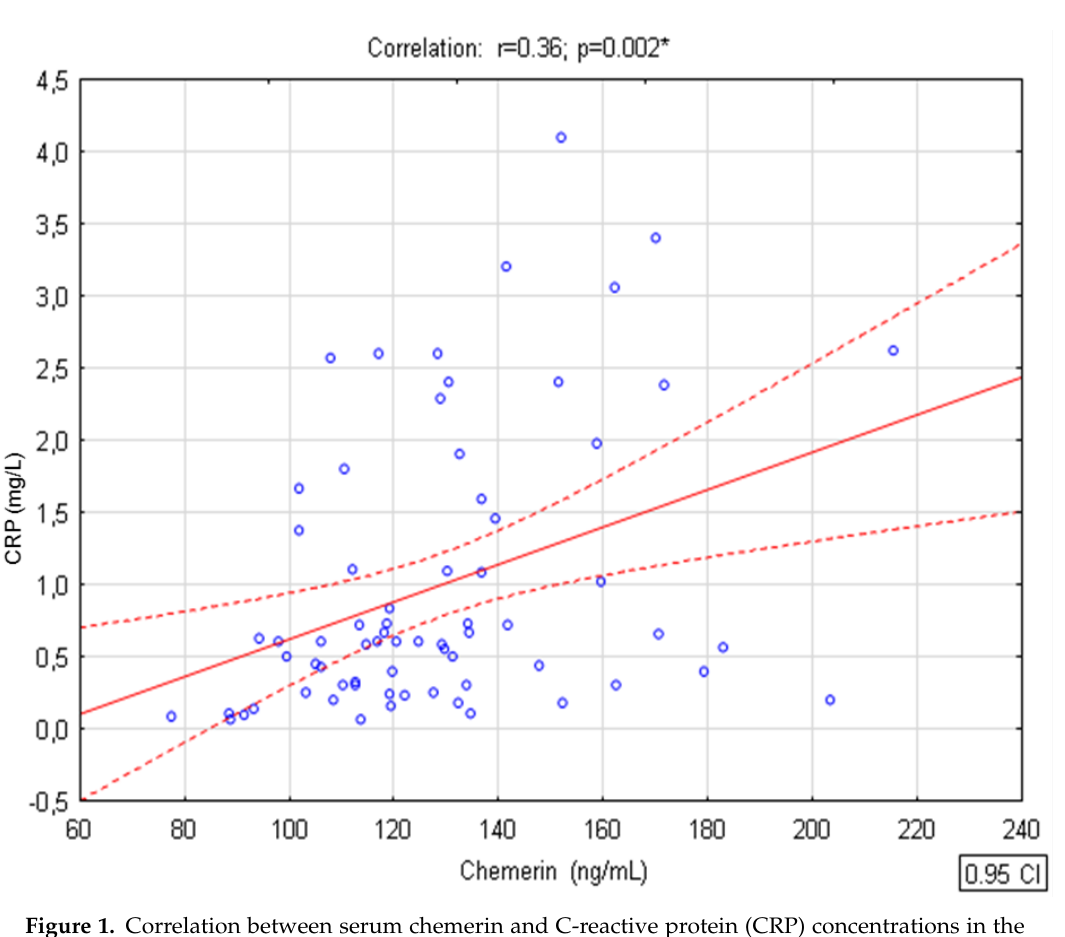
Table 2. Simple correlations between BMI z-score and biochemical parameters in children with obesity.